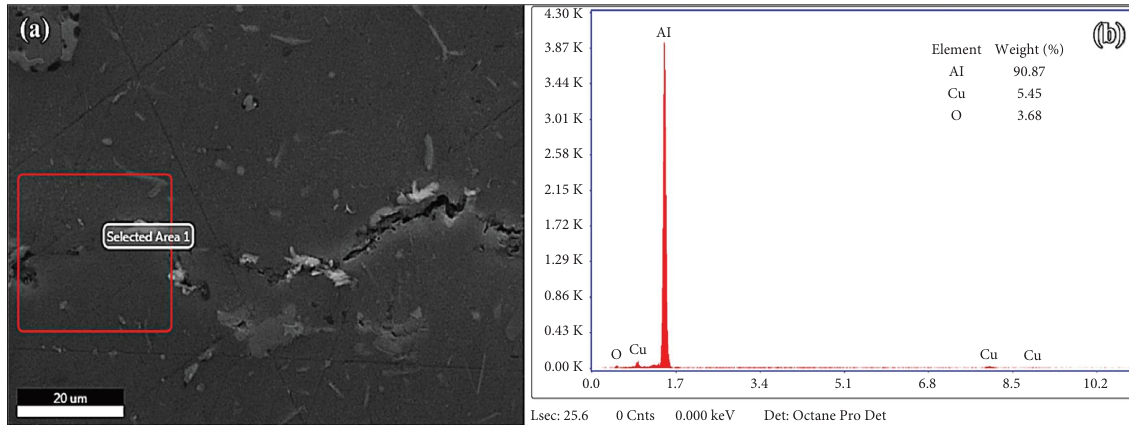
Figure 10: (a) EDS and (b) spectral analyses for the bonded area on the interface at 450 ° C.